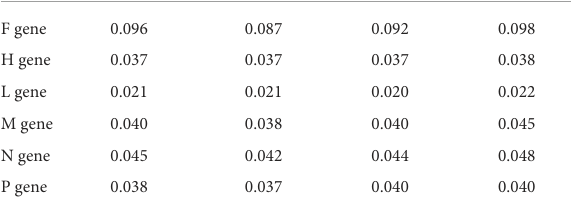
TABLE 3 Roles of nucleotide usage bias in the overall codon usage bias of PPRV genes. Rij(CAI,total) Rij(CAI,N1) Rij(CAI,N2)